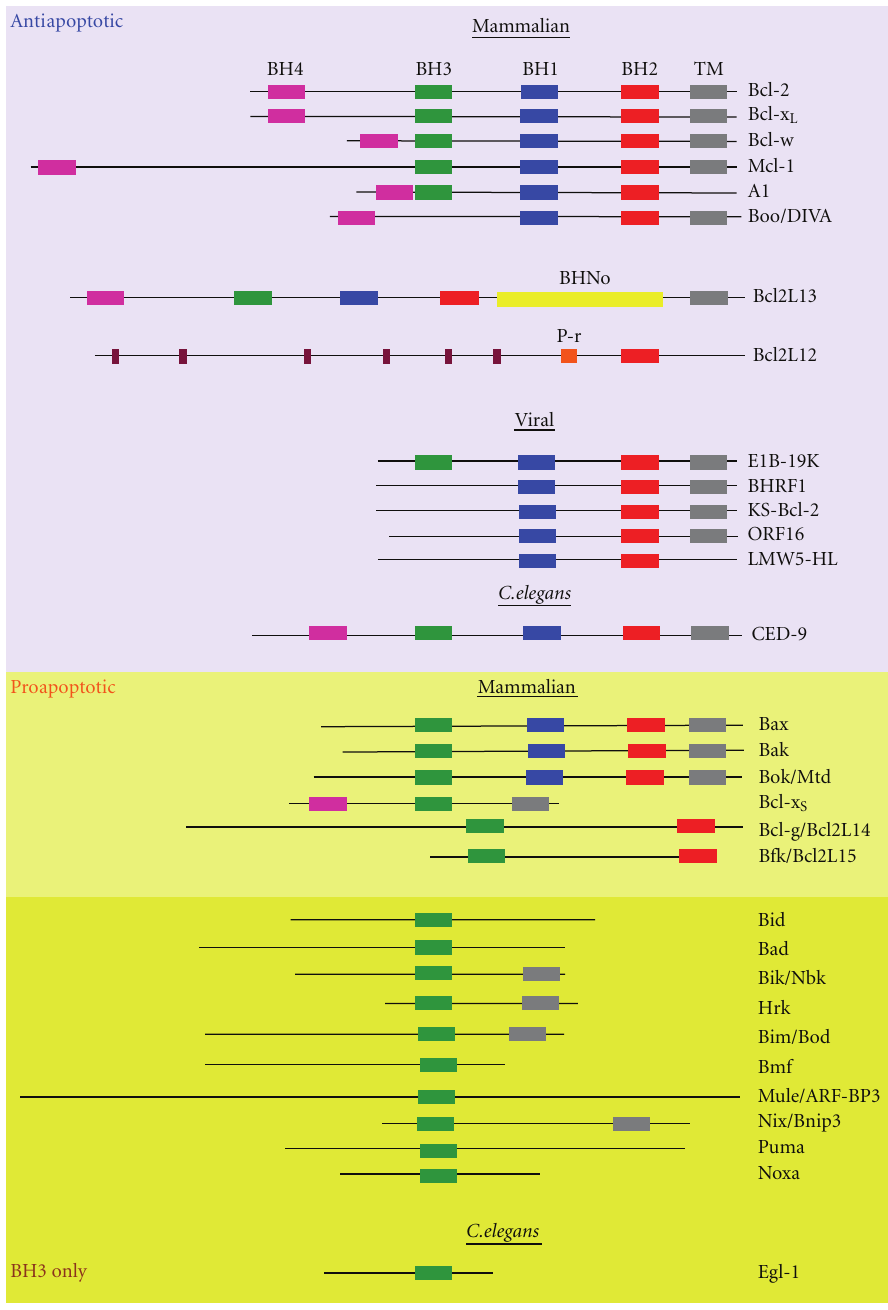
Figure 1: The Bcl-2 family. Domain structure of mammalian, viral, and C. elegans proteins. Shown are antiapoptotic “core” proteins, atypical Bcl-2-like proteins, for example, Bcl2L12 and Bcl2L13, proapoptotic multidomain, and BH3-only proteins. Bcl2L12 is characterized by six PxxP motifs located in the N-terminal and center portion of the molecule; these PxxP motifs are depicted as dark red boxes. BH: Bcl-2 homology domain; BHNo: no BH domain; TM: transmembrane domain. Bcl-2: B-cell lymphoma-2; Mcl-1: myeloid cell leukemia